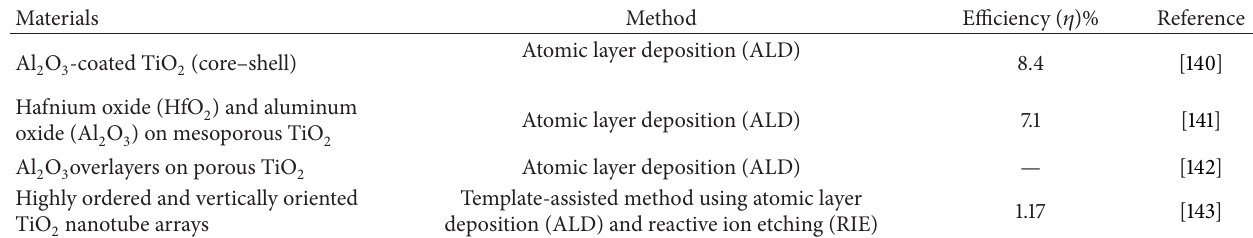
Table 2: Results of DSSC using ALD method.